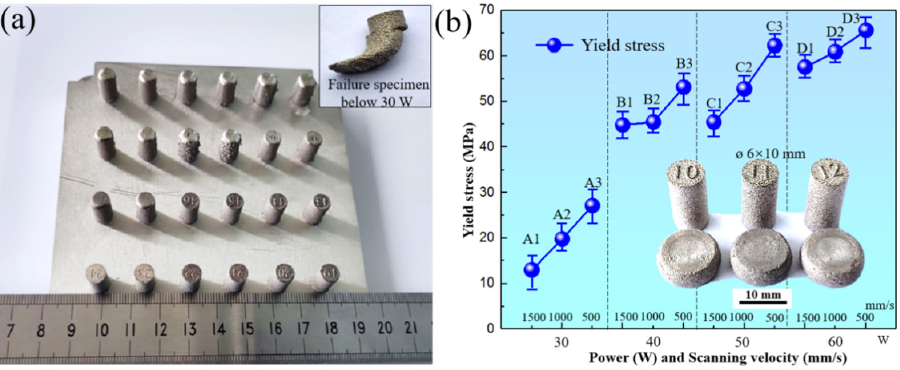
Figure 2. LBPBF Sn58Bi specimens ( a ) and uniaxial compression test results ( b ).